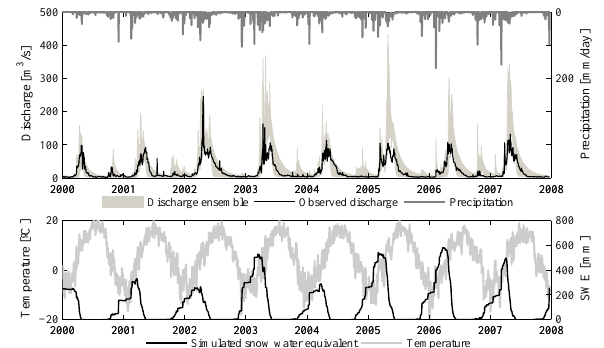
a Observed during the period 2000–2008. b